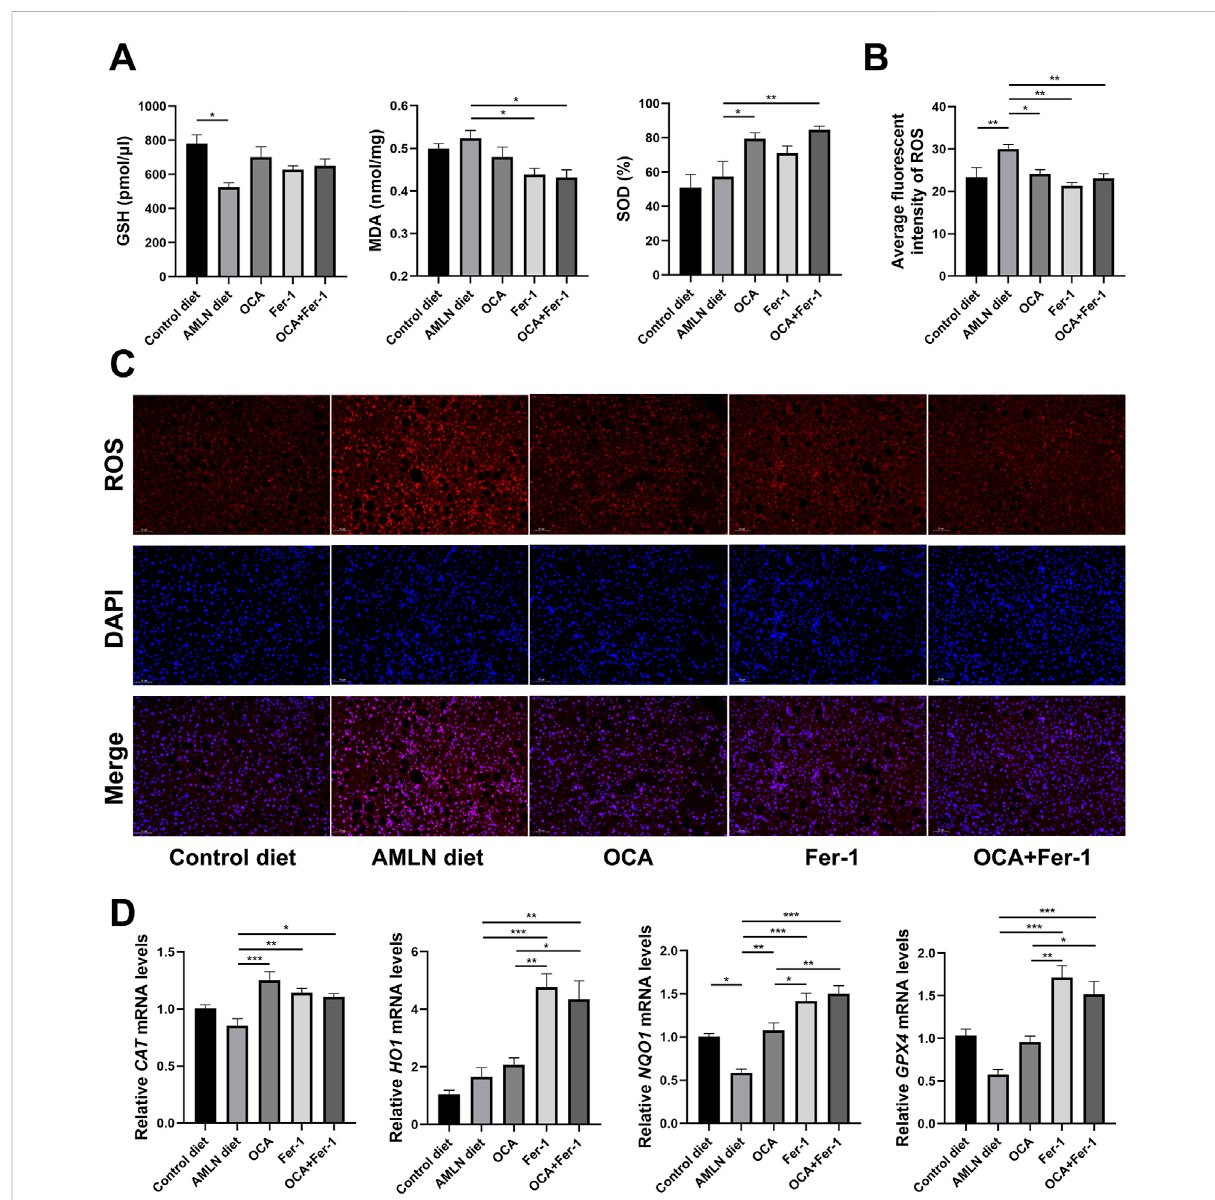
Combination of OCA and Fer-1 treatment protected mice against liver oxidative stress. (A) Levels of oxidative stress indicators (GSH, MDA and SOD)intheliver. (B) Average fl uorescenceintensity ofROS. (C) Dihydroethidiumstainingoflivertissues (scalebar:50 μ m). (D) Relativeexpressionof oxidative stress related genes ( CAT , HO1 , NQO1 and GPX4 ) in liver tissues. Data are shown as mean ± SEM. * p < 0.05, ** p < 0.01, *** p <